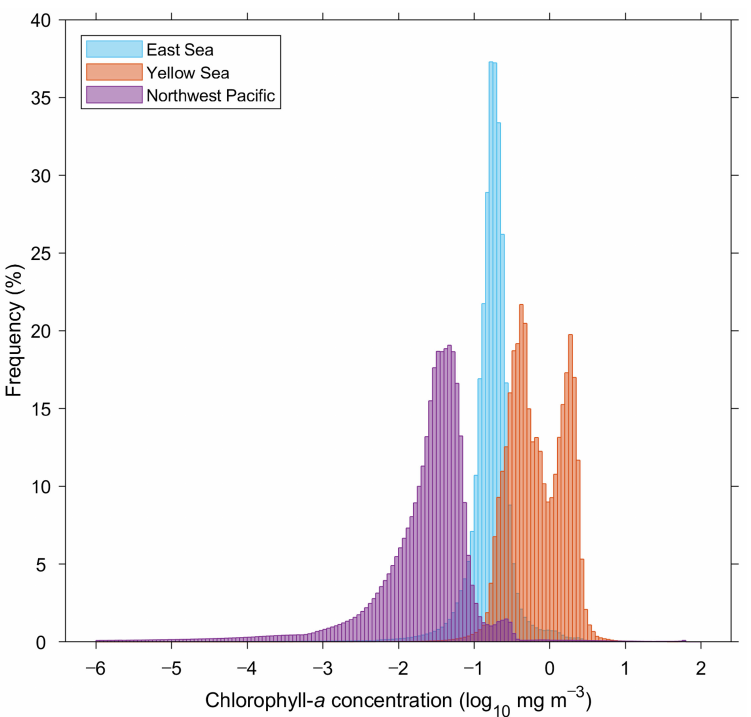
Figure 2. Frequency distribution of chlorophyll- a concentration in the GOCI observing area consisting of the East Sea, Yellow Sea, and Northwest